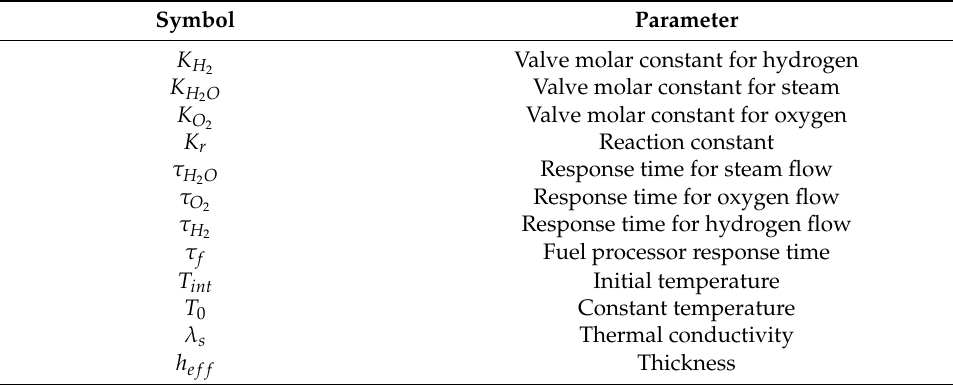
Table 1. Meaning of involved SOFC system parameters.